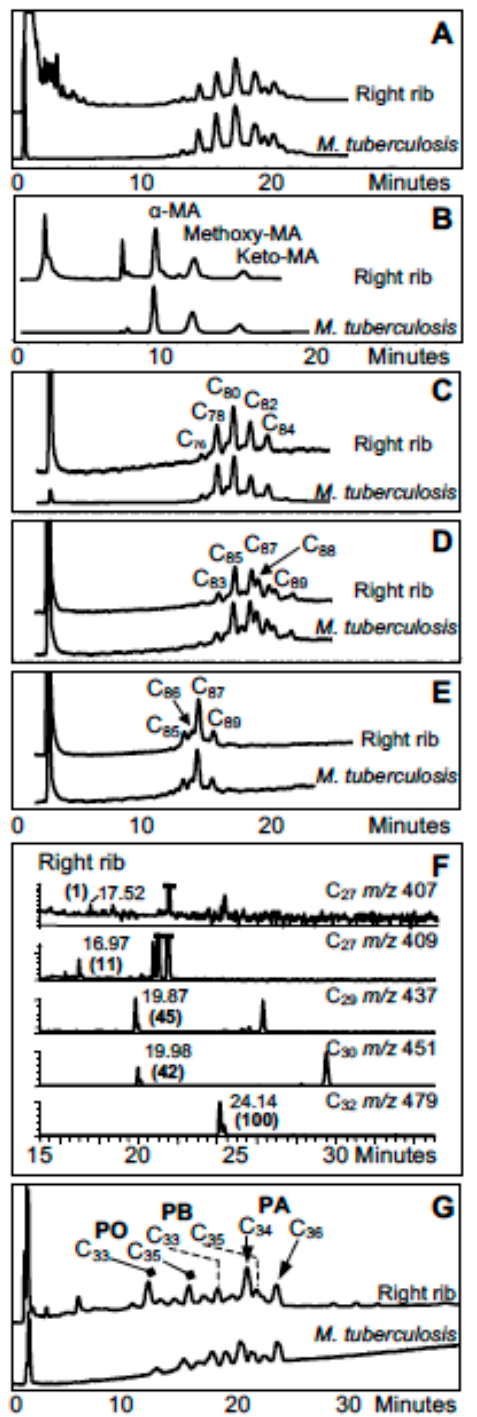
Figure 3. Lipid biomarker profiles for right rib of woman from Atlit-Yam [28,66]. ( A ) Total mycolates, reverse phase high performance liquid chromatography (HPLC); ( B ) Collected total mycolates (MAs), normal phase; ( C ) Collected α -mycolates, reverse phase; ( D ) Collected methoxymycolates, reverse phase; ( E ) Collected ketomycolates, reverse phase; ( F ) Gas chromatography mass spectroscopy (GC-MS) of mycolipenate (C 27 m/z 407) and mycocerosates (C 27 , C 29 , C 30 , C 32 ) characteristic of TB; ( G ) Reverse phase HPLC of phthiocerol family— PA phthiocerol A, PB phthiocerol B, PO phthiodiolone. Comments: Excellent MTB MA and mycocerosate profiles, with weak mycolipenate; good profiles of phthiocerol family. Verdict: Certain MTB.